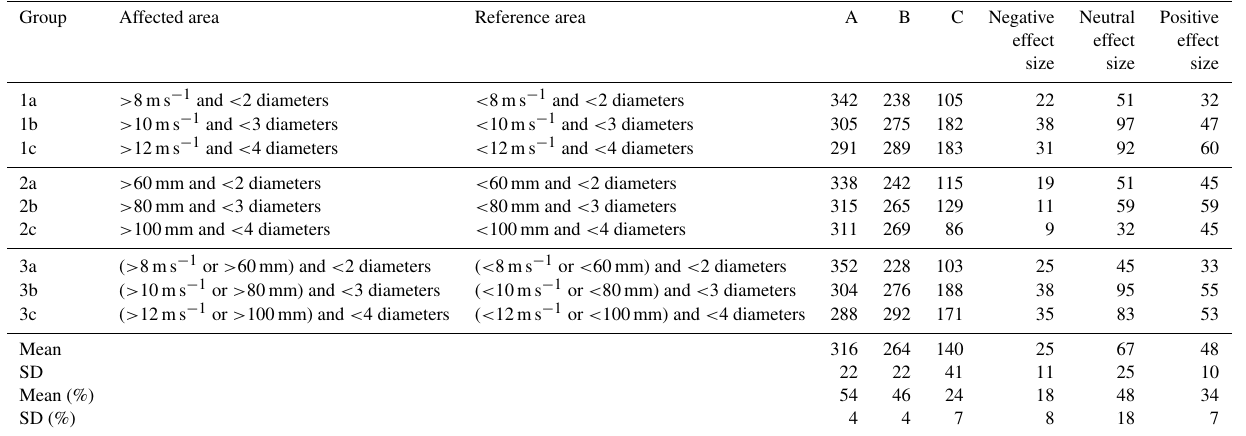
Table A1. Criteria for distinguishing between the affected and reference areas following the passage of an individual cyclone and the number of events according to each specific definition. Group 1 groups definitions are based on wind speed, group 2 definitions are based on precipitation, and group 3 definitions are based on both wind speed and precipitation. All three definitions include an estimate of the storm path based on a multiple of the reported storm diameter. Column A denotes the number of events for which data were lacking so that the effect size could not be calculated; column B denotes the number of events for which all required data were available; column C denotes the subset of B for which the data passed the quality control; ES refers to effect size. A total of 580 unique tropical cyclones were considered in this